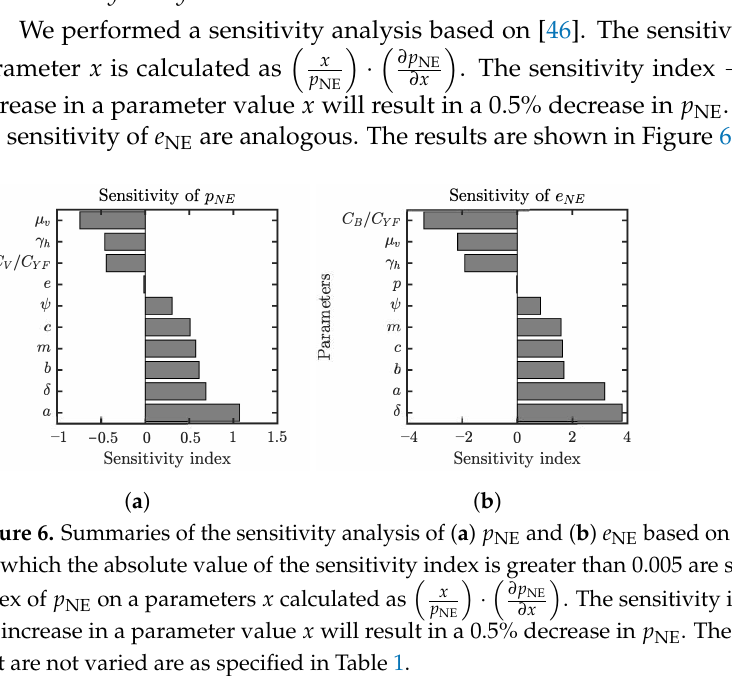
(cid:16) (cid:17) (cid:16) ∂ p (cid:17) x · NE . The sensitivity index − 0.5 means that p NE ∂ x